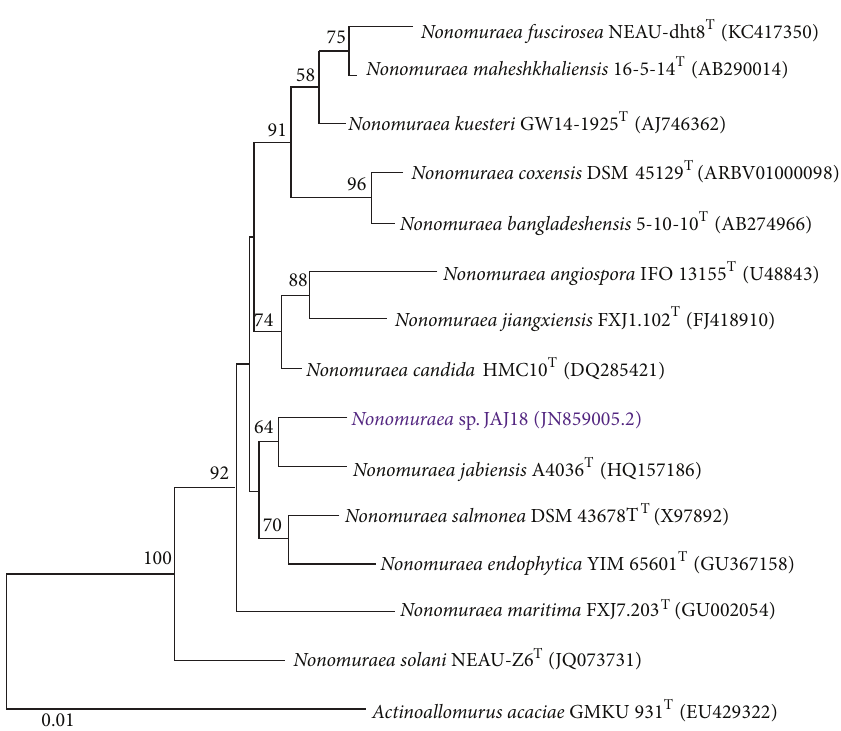
Figure 1: Neighbour-joining tree based on almost complete 16S rRNA gene sequences of JAJ18. The phylogenetic tree shows the relationships between Nonomuraea sp. JAJ18 and members of the genus Nonomuraea . Actinoallomurus acacia GMKU 931 T was used as out-group. Numbers at nodes indicate the levels of bootstrap support (%) based on a neighbour-joining analysis of 1000 resampled datasets. Score bar represents 1 nucleotide substitution per 100